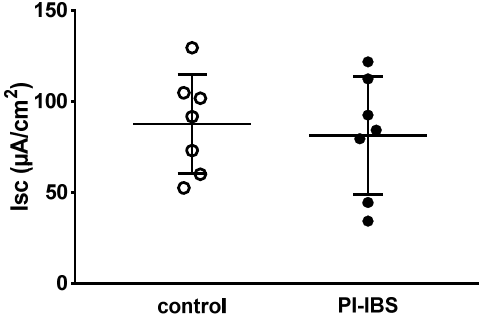
Figure 2. Basal active electrogenic anion secretion was characterized by measuring the spontaneous short-circuit current (Isc) of sigmoid colon mucosae from patients with post-infectious irritable bowel syndrome (PI-IBS) and their respective controls (n = 7 each; n.s.).